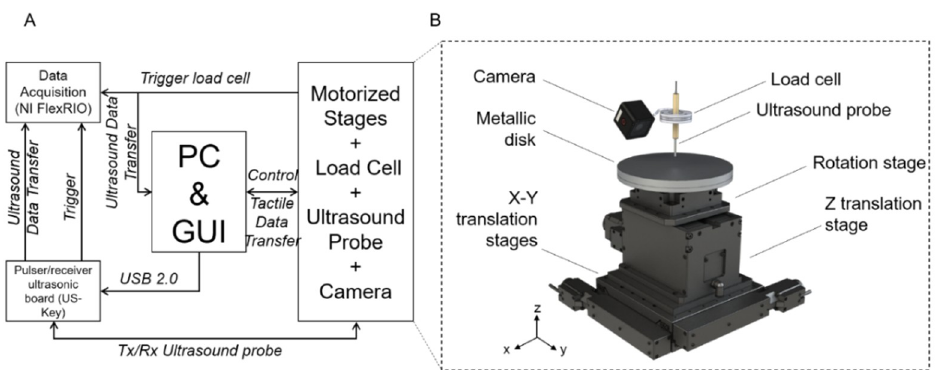
Figure 2. ( A ) Block diagram of the experimental setup. ( B ) Experimental setup showing the different components.